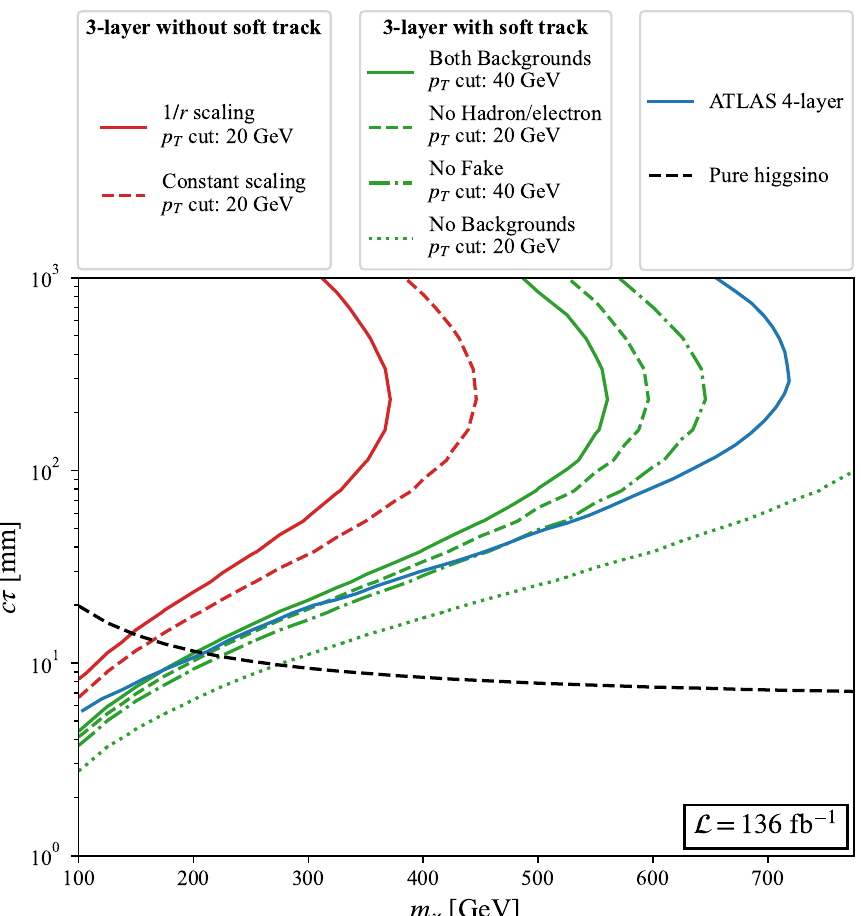
Figure 9 . The sensitivity in the ( m χ , cτ ) plane of our proposed tracklet searches for an EW doublet fermion, for an integrated luminosity of 136 fb − 1 . The blue curve corresponds to the doublet reach of the 136 fb − 1 ATLAS 4-layer search, ref. [9] . The two red curves correspond to the pure 3-layer search with conservative and agggressive scalings for the fake tracklet background as described in section 3.3. The green curves correspond to a 3-layer search with soft track requirement as described in section 3.4, with the different line styles corresponding to different background benchmarks. For the dotted green curve we assume all backgrounds are eliminated by the soft track requirement; for the dot-dashed green curve the hadron/electron background is left unchanged and the fake tracklet background is eliminated; for the dashed green curve, the hadron-electron background is eliminated and the fake tracklet background is reduced to its level in the 4-layer search; for the solid green curve the hadron/electron background and fake backgrounds are retained at their levels in the 3- layer and 4-layer searches, respectively. The values of the tracklet p T cut, chosen in each case for maximal sensitivity along the (black dashed) pure EW doublet curve, are listed in the